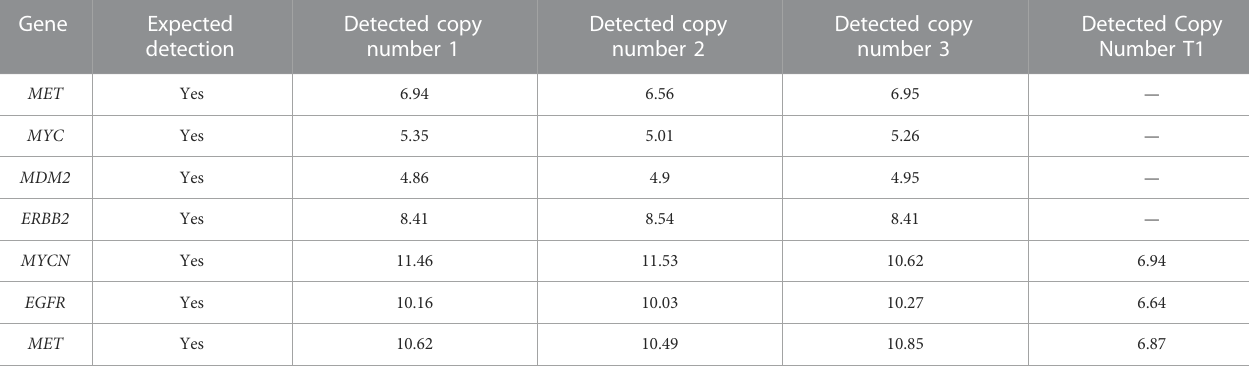
TABLE 7 Accuracy. The LOD of CNV